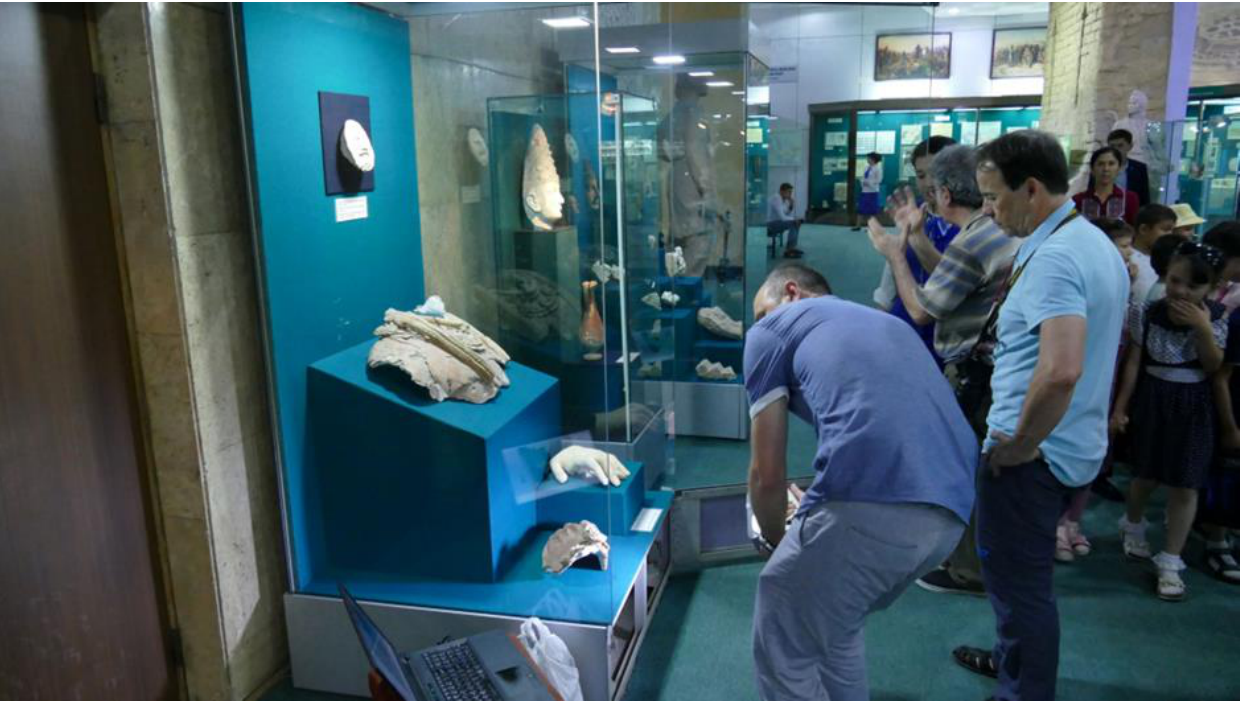
Figure 1. 3D scanning under tourist traffic in Tashkent at the National Museum of the History of Uzbekistan.